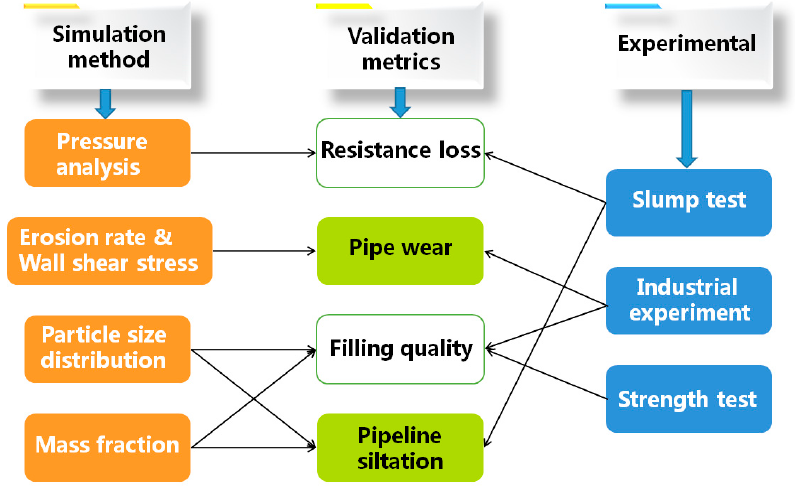
Figure 11. Internal relations of research methods.